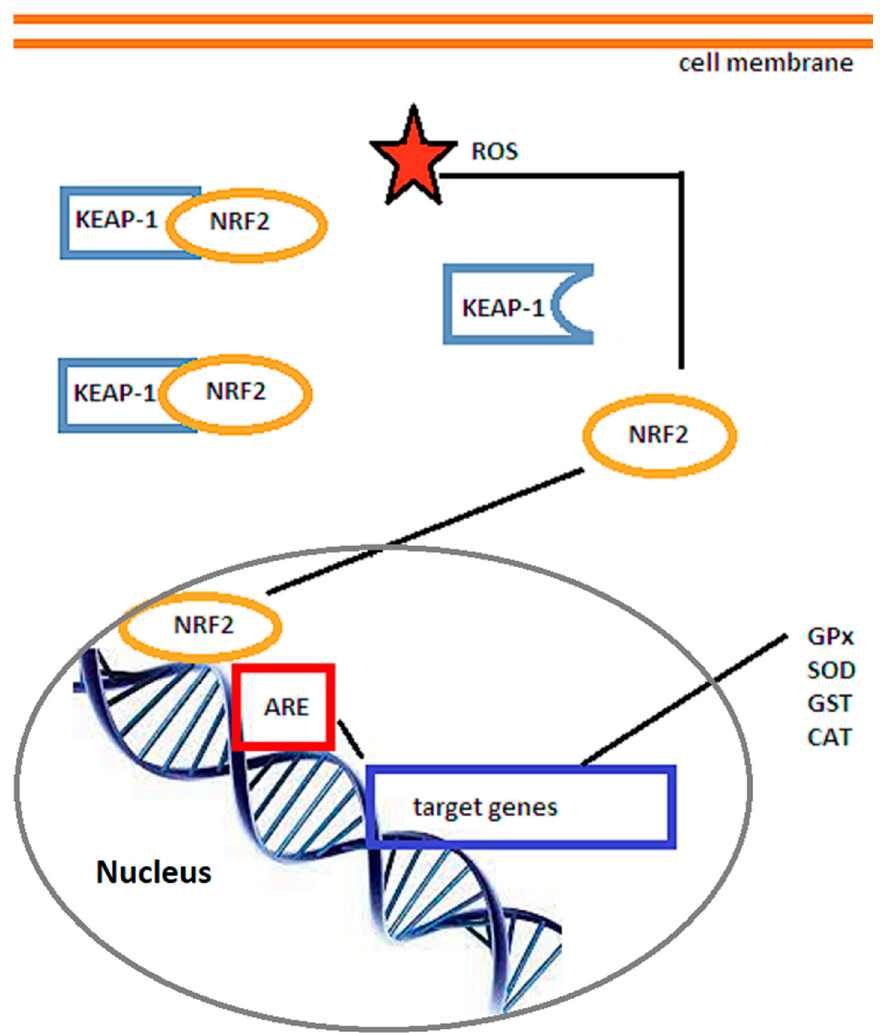
Figure 2. Schematic representation of the Nrf2/ARE signaling pathway. Under the influence of reactive oxygen species (ROS), the Nrf2/ARE complex dissociates and Nrf2 translocates to the nucleus, where it triggers the expression of genes with ARE (antioxidant response element) sequence in their promoters, leading to the production of endogenous antioxidants such as glutathione peroxidase (GPx), superoxide dismutase (SOD), glutathione S-transferase (GSH), and catalase (CAT). Adapted from Vasconcelos et al. [109].